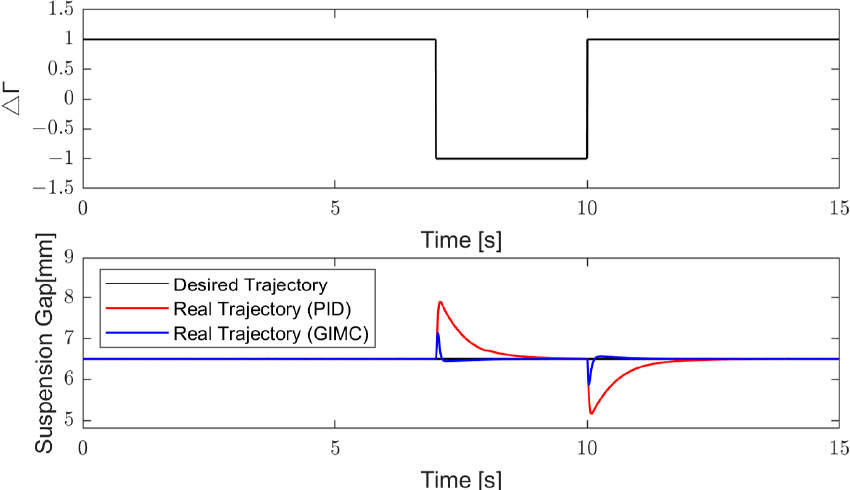
Figure 17. The result of simulation 2.